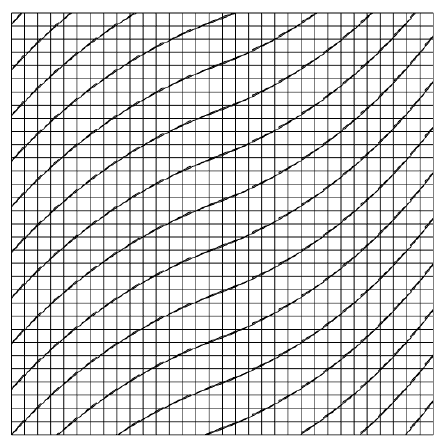
Figure 4. Intersection between the mesh of the skin and the gap distribution. The gaps are resin rich areas, so a higher value of gap area means a decrease in the material properties of the laminate. The ’modified’ rule of mixtures (Equations (5)–(8)) is used to scale the elastic properties of each element according to the gap area fraction. The gap area fraction is defined as the value of the gap area in each element divided by the area of the mesh